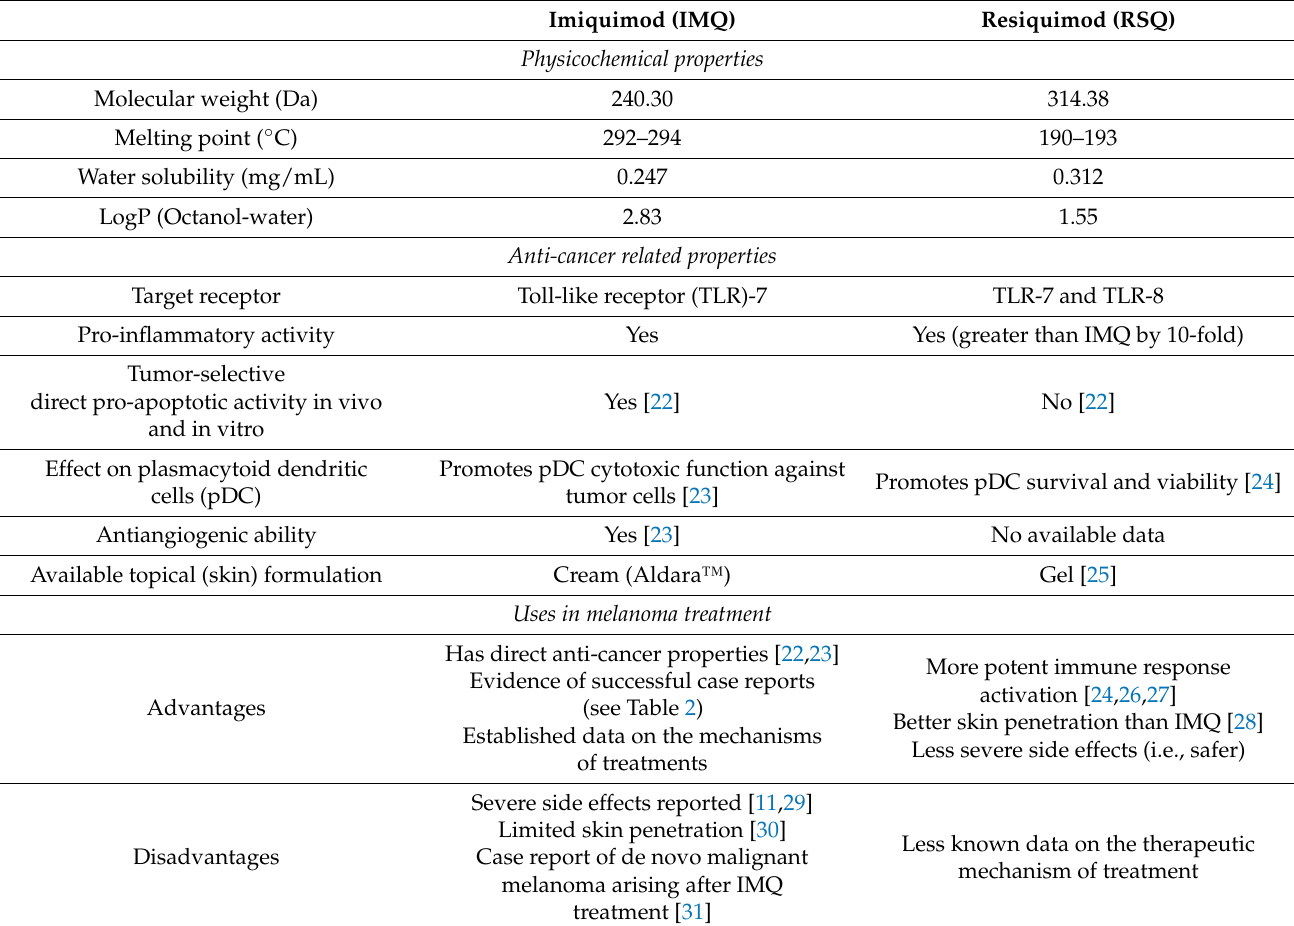
Table 1. Physicochemical, anti-cancer related properties of IMQ and RSQ and their use in melanoma